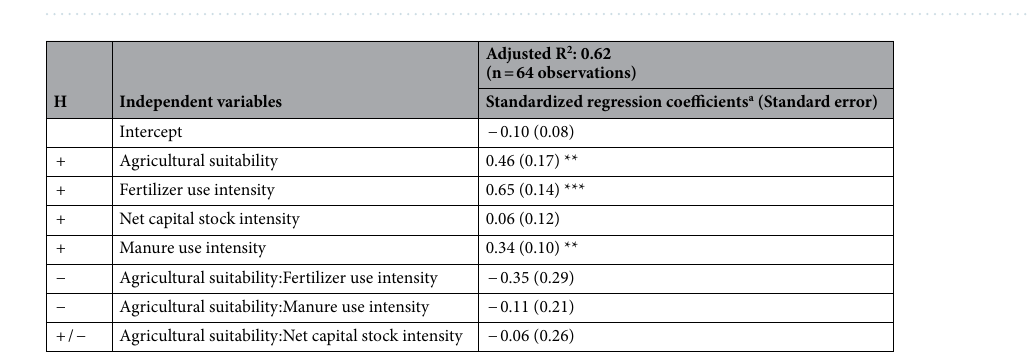
Table 1. Model results: coefficients of the independent variables. Fertilizer use intensity and agricultural suitability are positively associated with yield. a Significance levels: p < 0.1; * p < 0.05; ** p < 0.01, *** p < 0.001.